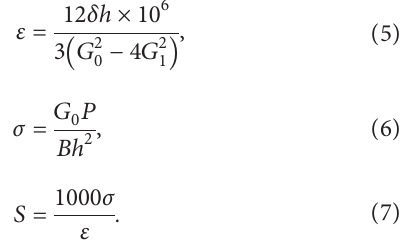
Figure 3 indicates the configuration of the test